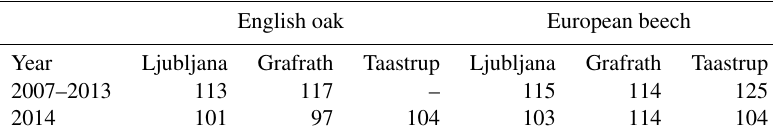
Table 2. The day of year (DOY) for leaf unfolding for English oak and European beech at sites Ljubljana, Grafrath and Taastrup, with both an average between 2007 and 2013 and the unfolding in 2014. No long-term observations for leaf unfolding of English oak in Taastrup are